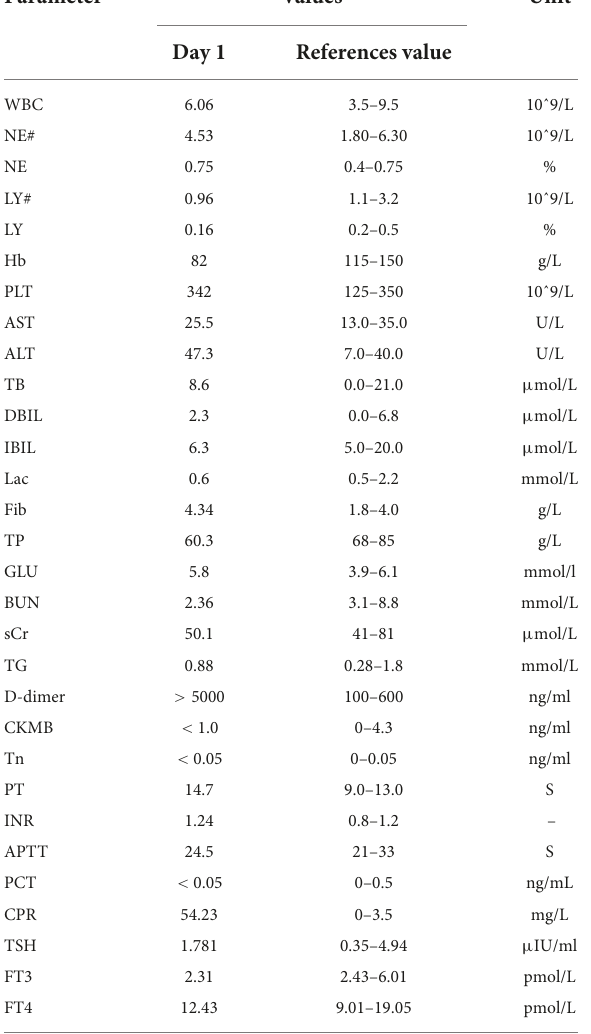
TABLE 1 The patient’s laboratory data.